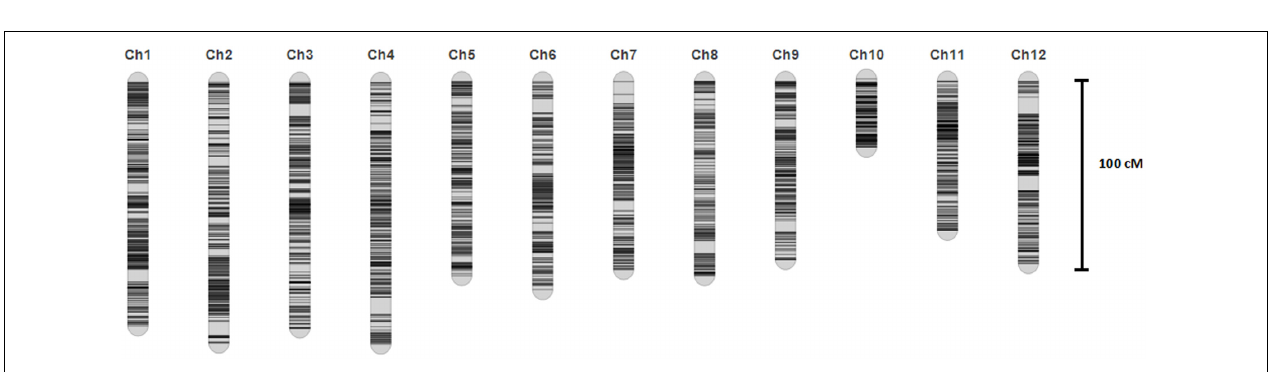
FIGURE 2 | The high density map of the BRIL population.